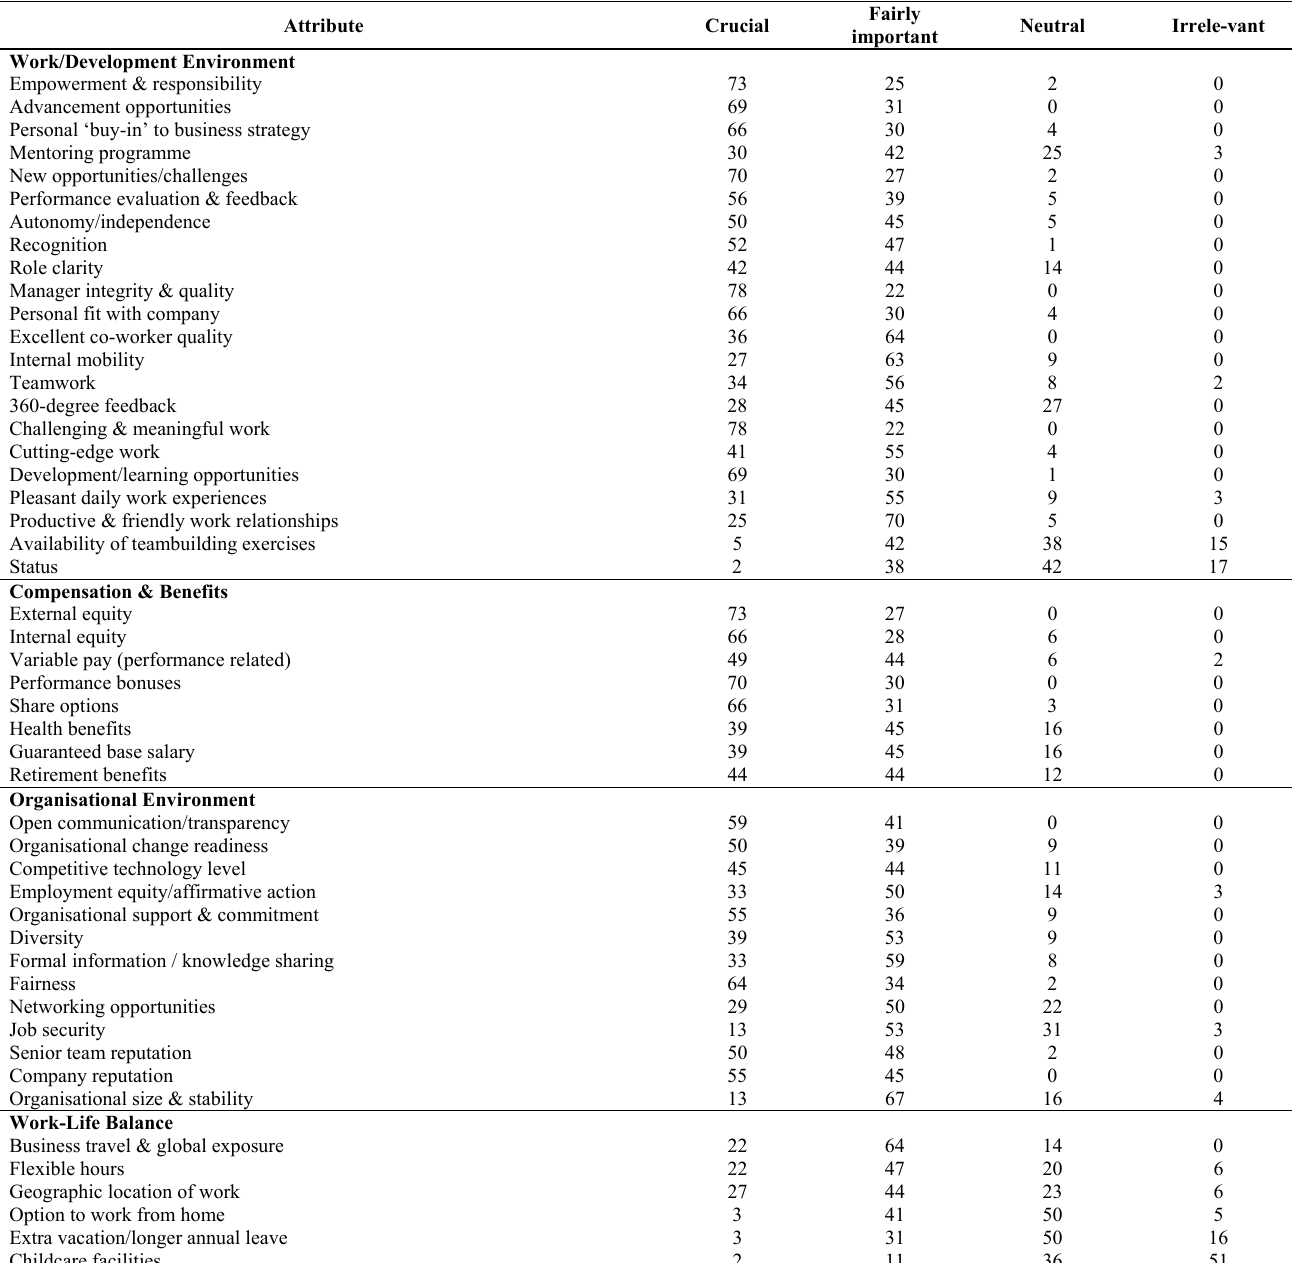
Fairly Neutral Irrele-vant important